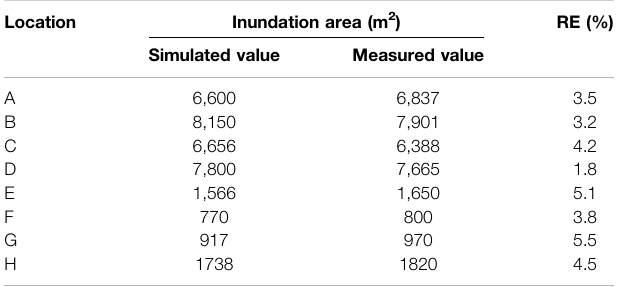
TABLE 3 | The comparison of measured results and simulated results (t (cid:2) 4 h). Location